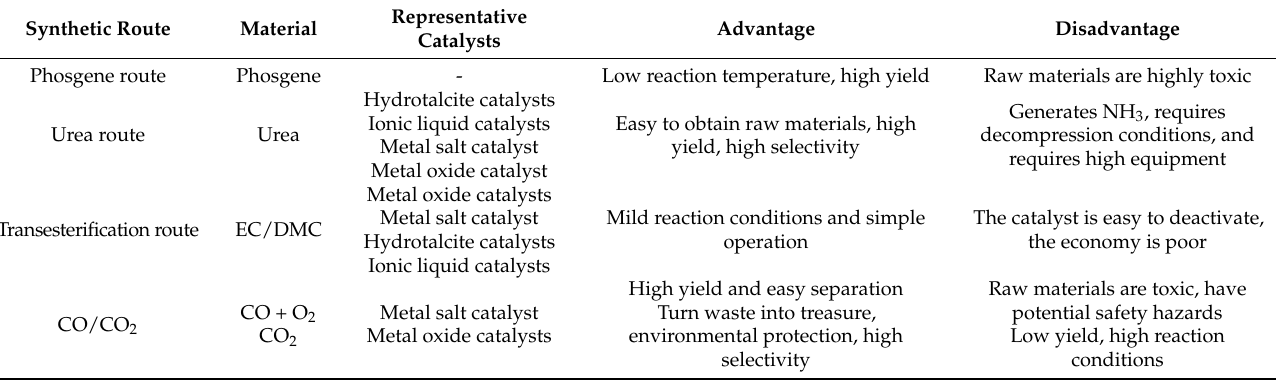
Table 2. Comparison of the main synthetic routes to